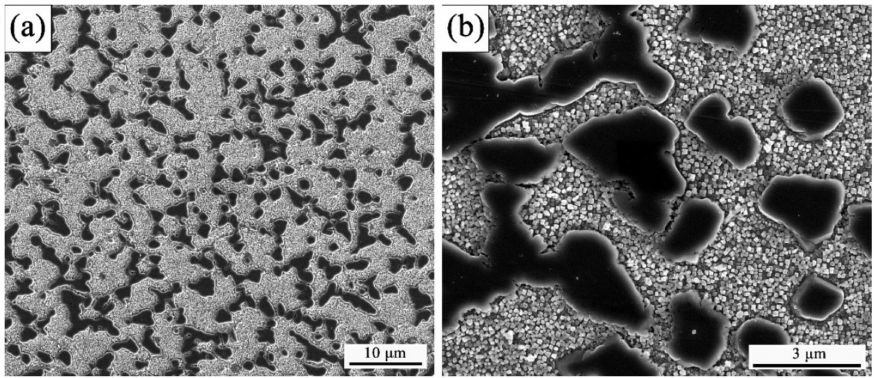
Figure 2. The as-received microstructure of the hot-extruded GH4151 alloy at di ff erent magnifications: ( a ) 5000 × ; ( b ) 25000 ×